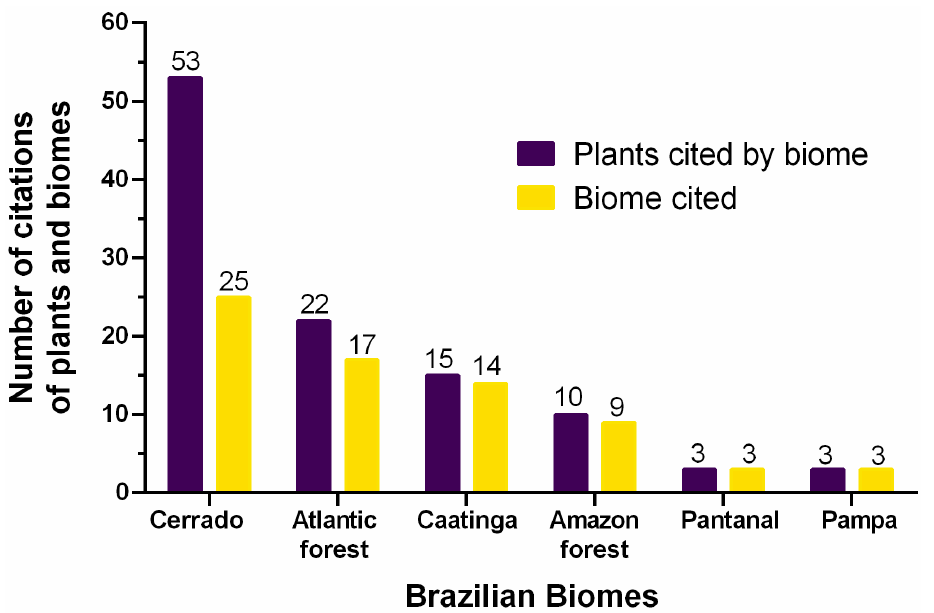
Figure 1. Number of plants cited per biome and articles citing each biome.